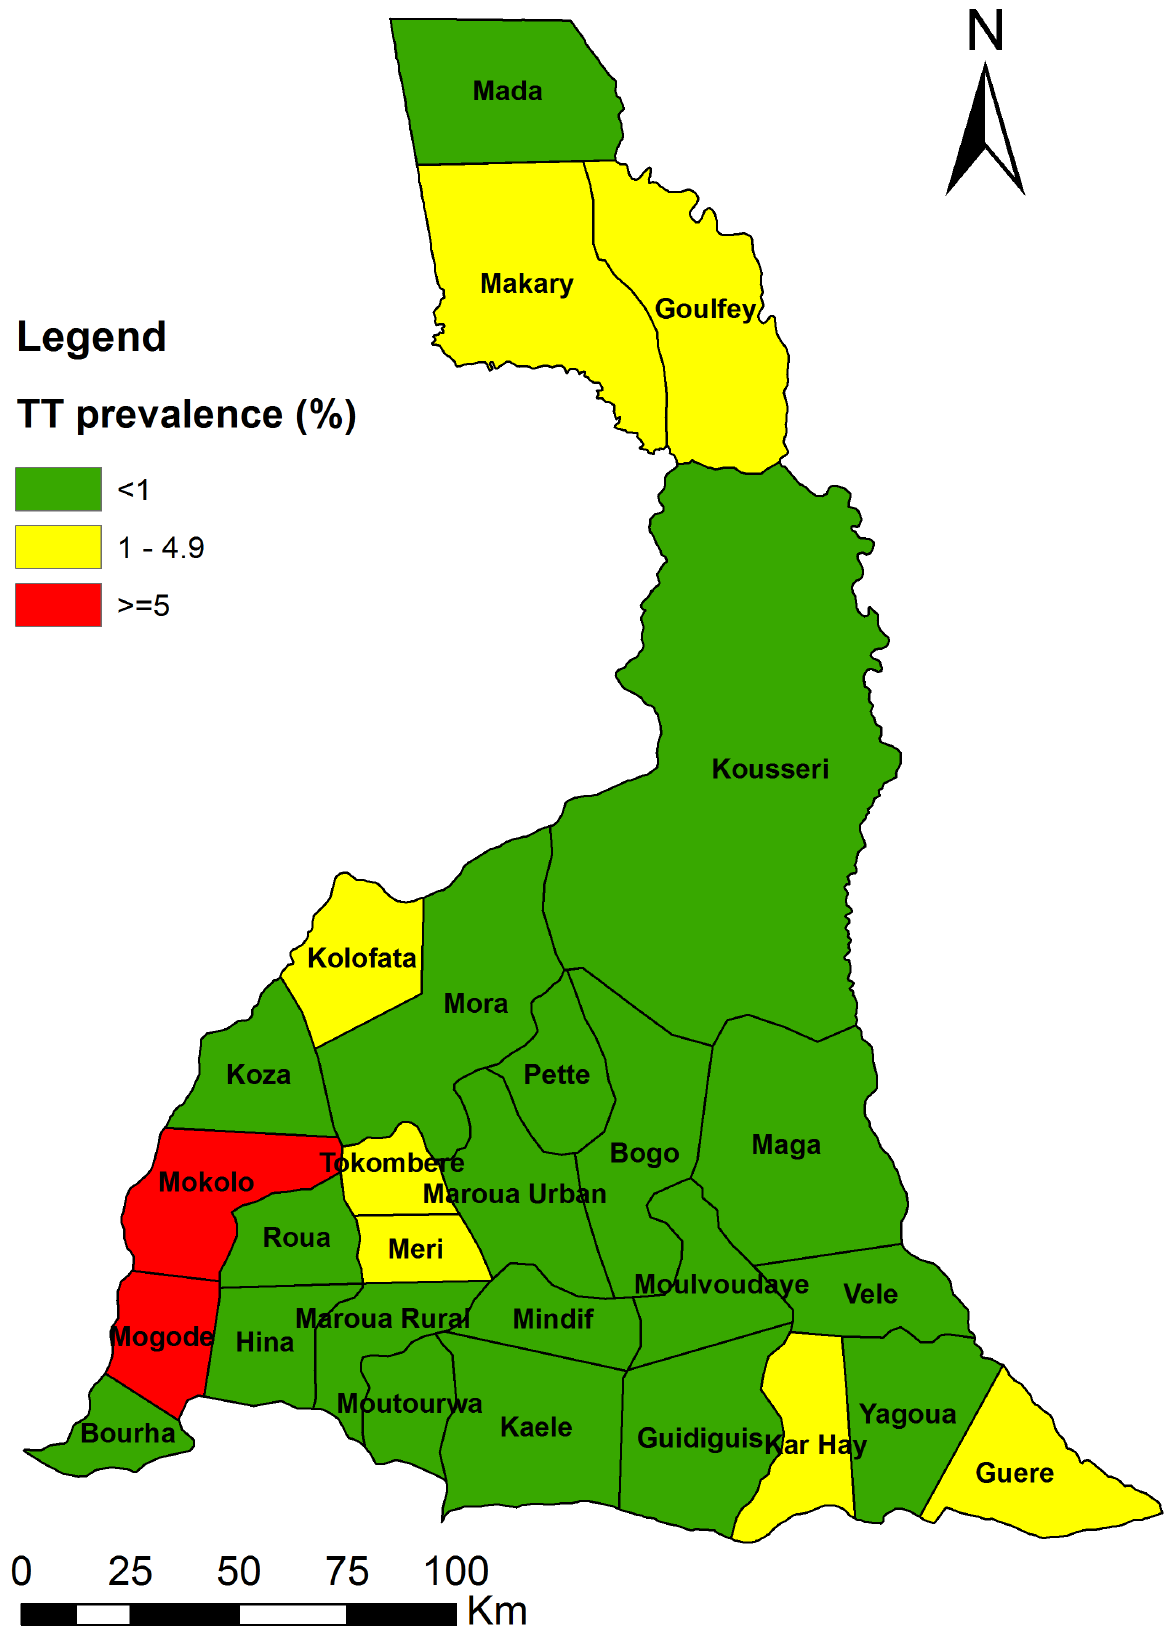
Figure 2. Distribution of TT prevalence in adults aged 15 years and over in the Far North region.